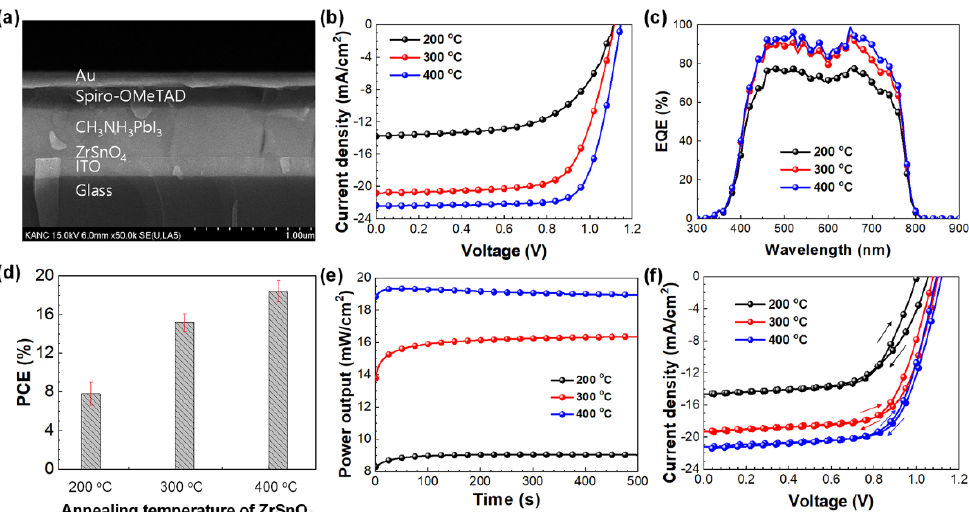
Figure 4. FE-SEM image for the cross-section of device ( a ), J–V curves ( b ), EQE spectra ( c ), statistical analysis of PCEs of the devices ( d ), stabilized power output measurements ( e ), and hysteresis analysis of the PSCs employing the sol-gel-driven ZrSnO 4 ETLs with different temperature ( f ). The statics of PCE data was collected from more than 12 devices in each condition. Table 1. Photovoltaic parameters of the PSCs based on ZrSnO 4 ETLs with varying annealing temperature. Annealing Temperature [°C]